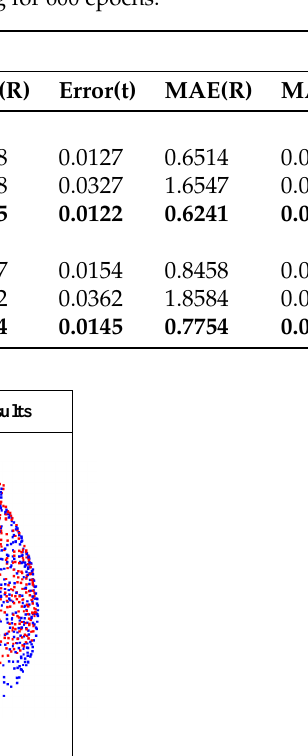
Table 2. Results of metrics with different loss functions training for 600 epochs.